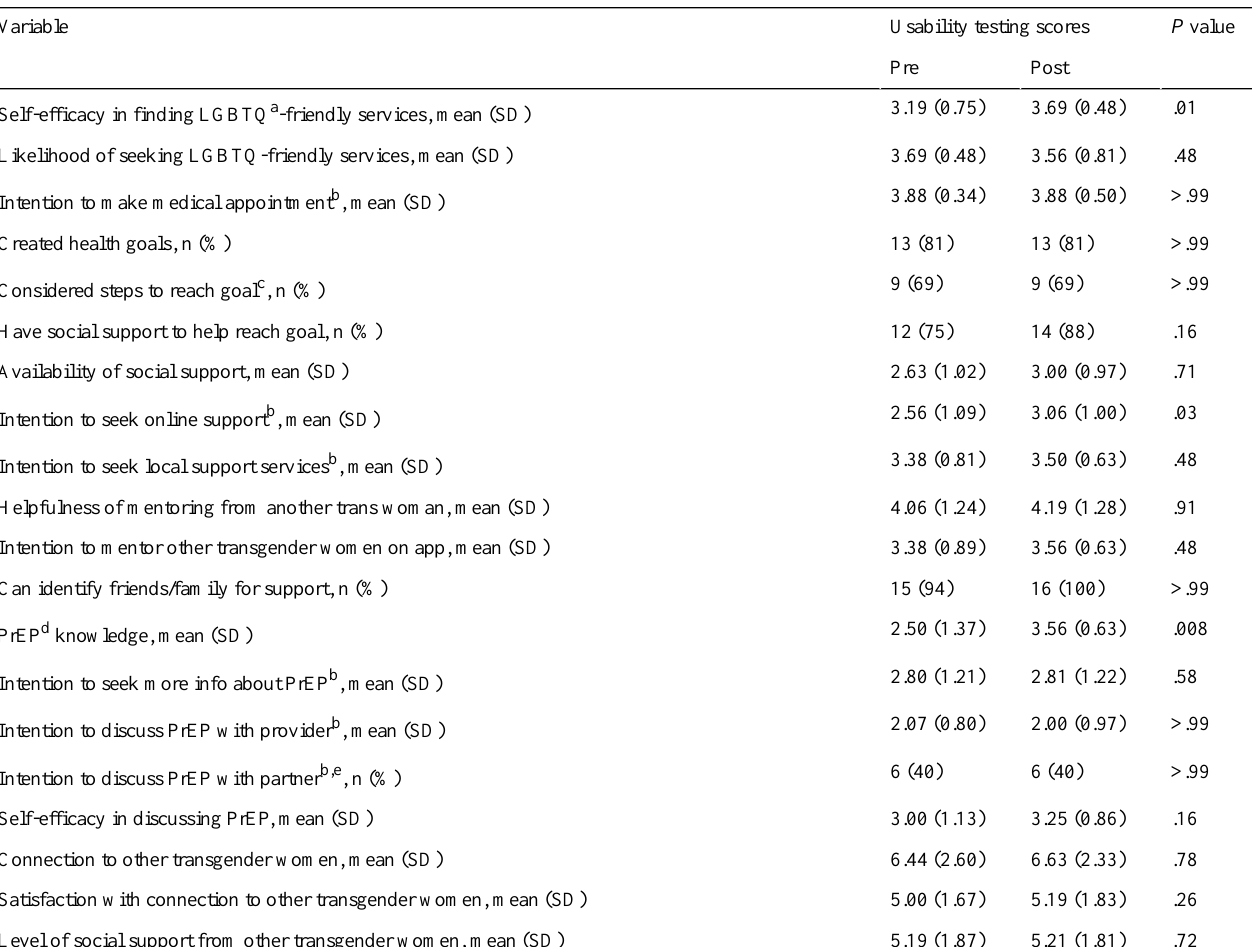
Table 3. Self-efficacy, intention, knowledge, goal setting, and social support: pre– and post–usability testing